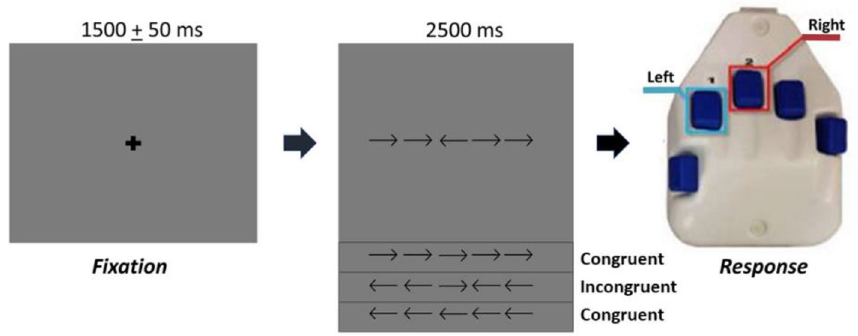
Figure 1. Flanker task design. For each trial, the participants fixated on a crosshair for 1500 ± 50 ms, then a series of five arrows appeared for 2500 ms. Upon arrows appearing, the participants responded with their right hand regarding the center arrow pointing to the left (2nd digit) or right (3rd digit). In the congruent condition, the flanking arrows pointed in the same direction as the middle arrow. In the incongruent condition, the flanking arrows pointed in the opposite direction than the middle